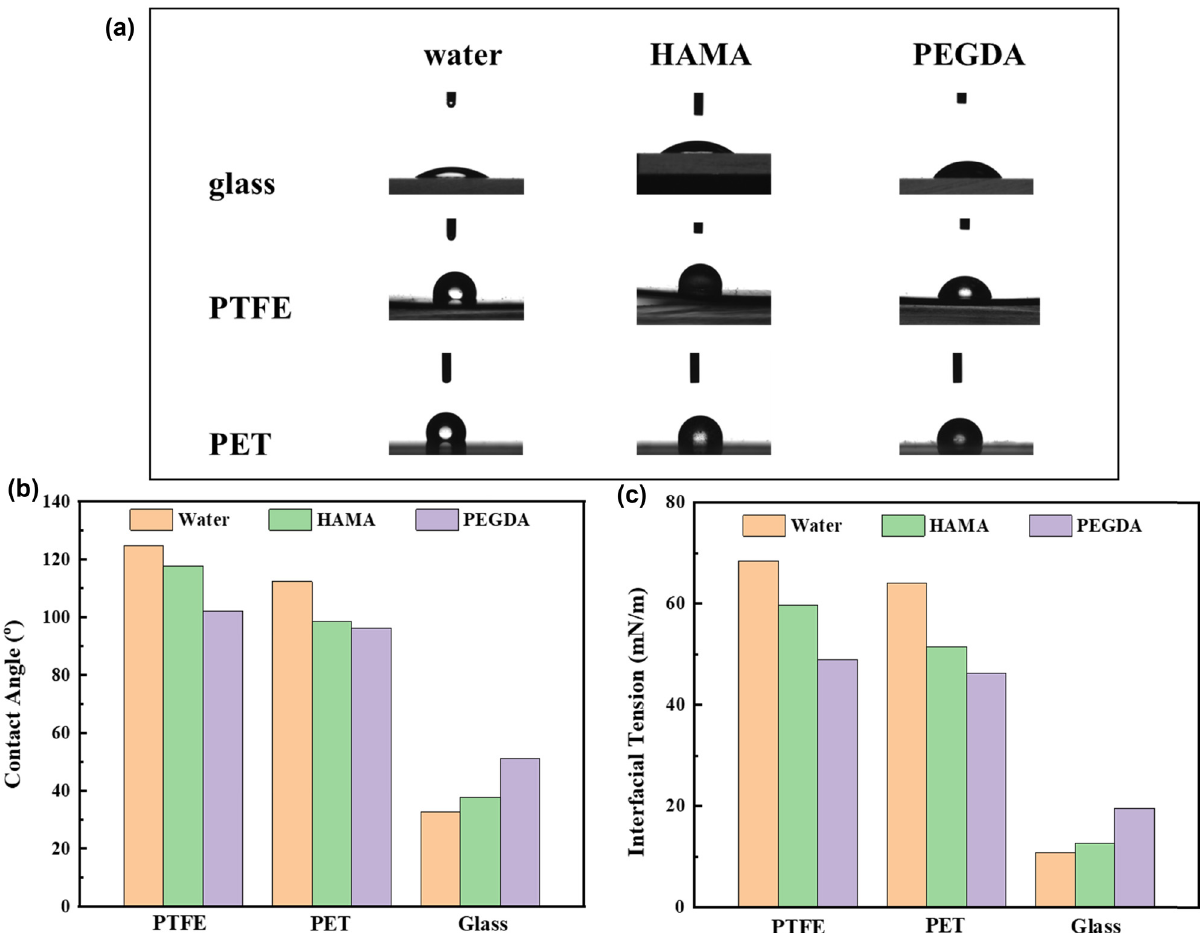
Figure 5: ( a ) The surface contact angle images of water, HAMA - gel, and PEGDA precursor on di ff erent substrates, respectively. The data of ( b ) surface contact angle and ( c ) surface tension were calculated in